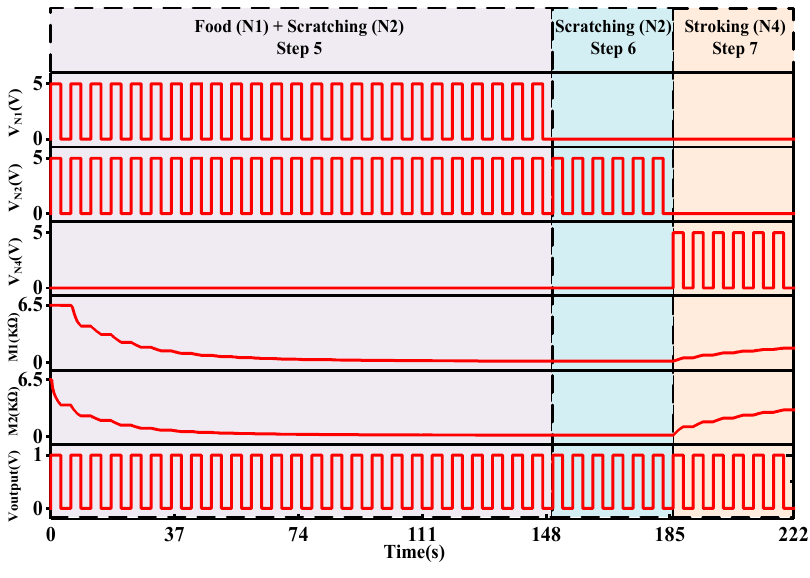
Figure 10. The transient response of Step 5 to Step 7.